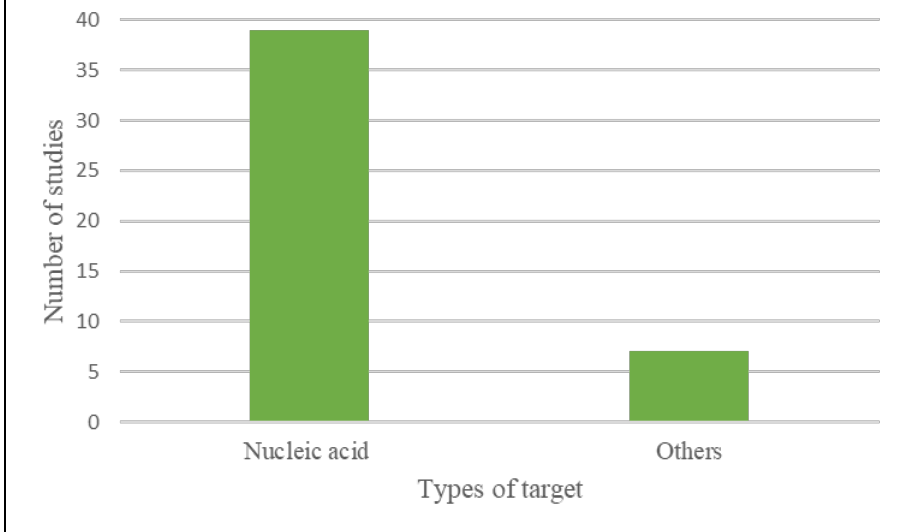
Figure 4. Types of targets used in CRISPR-Cas system-based bacterial detection.